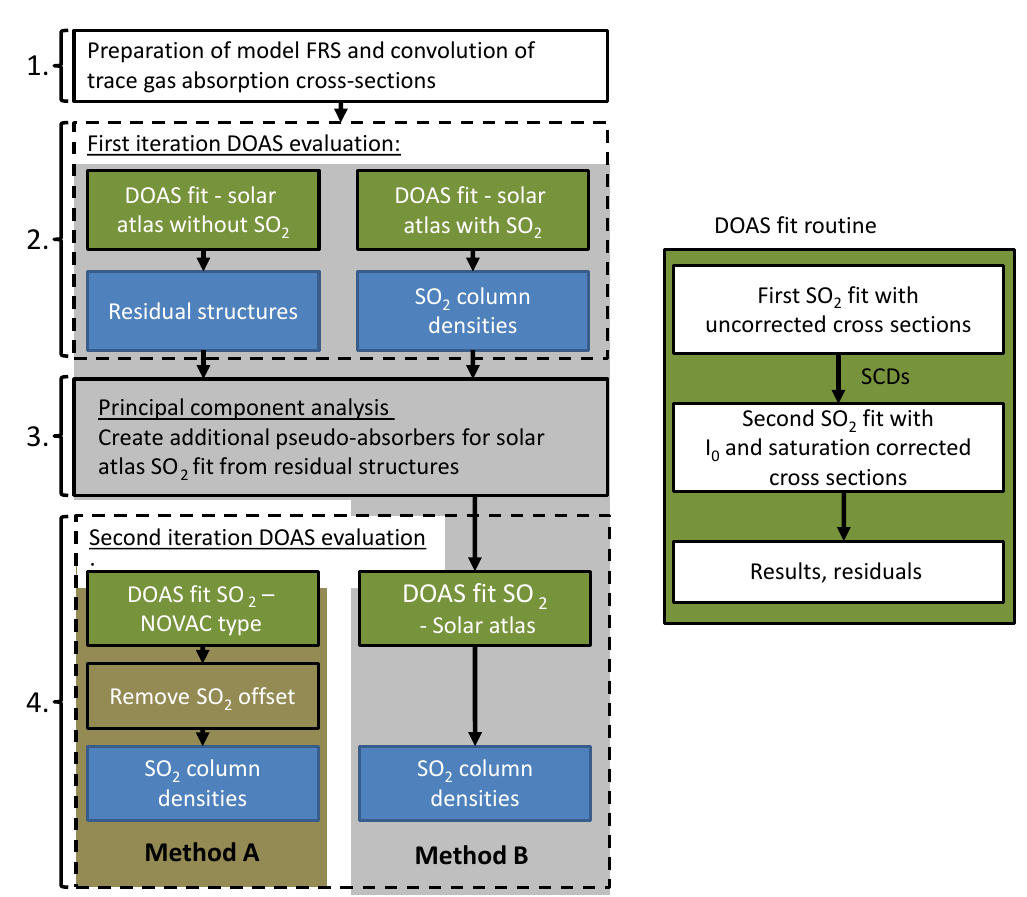
Figure C1. Flow chart of the evaluation steps that were used in order to create the SO 2 column densities from methods A and